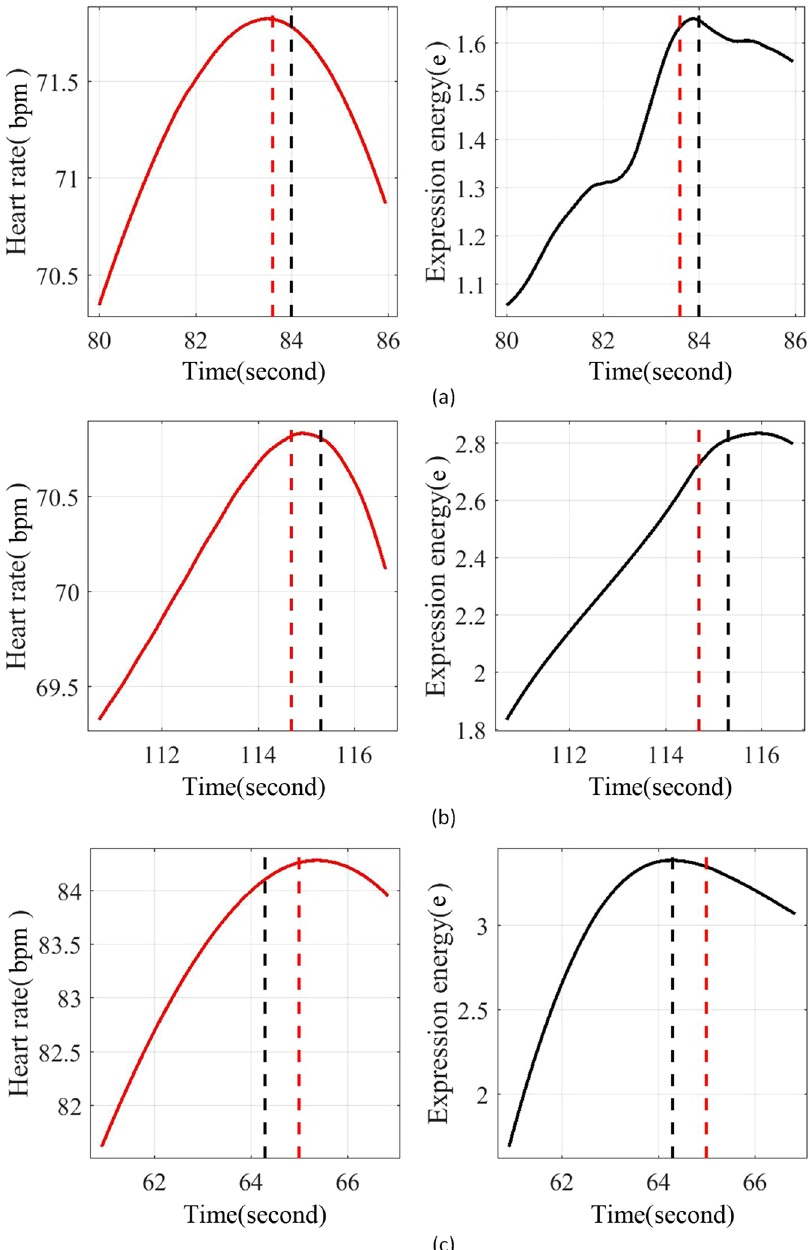
Figure 5. The correlation examples from three subjects. These examples are chosen from the high density region defined by [ − 0.03,0.03] × [ − 0.01,0.01] × [ − 1.0,1.0] of 3D probability map. The red and black dashed lines respectively denote the temporal positions where the correlation